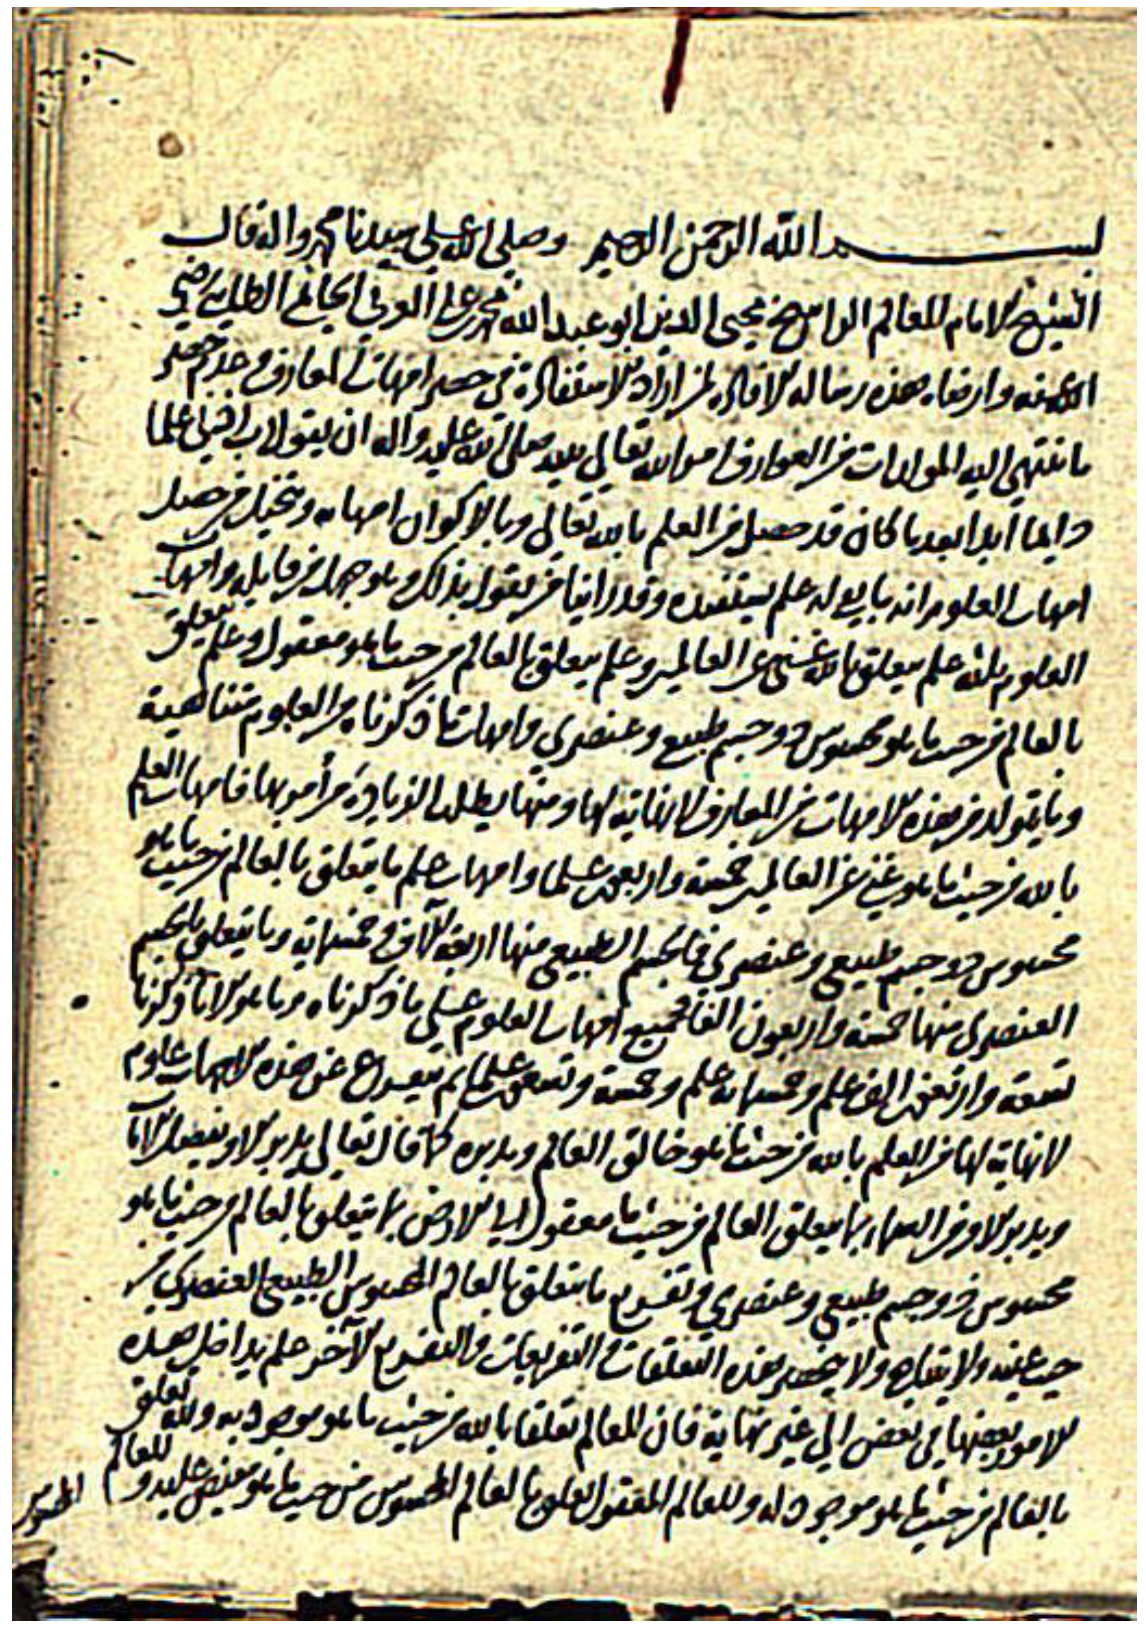
Figure A2. The first page of the MS Ayasofya 4875, f.200b.